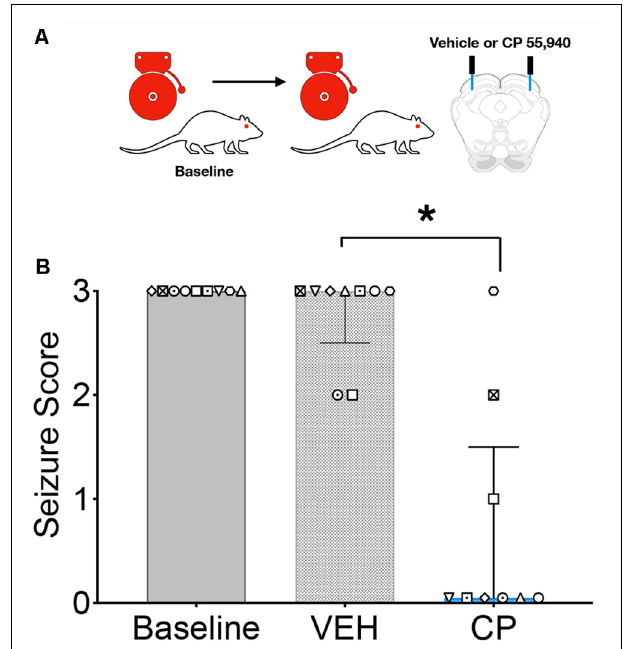
FIGURE 2 | Intracollicular injection of the CB1/2 receptor agonist, CP 55940 (CP) attenuates audiogenic seizures in GEPRs. (A) Schematic of the testing scheme; animals were tested with a baseline test session before a vehicle-treated session and a CP treated session. A baseline is shown only once, as in this experiment all animals displayed baseline scores of three across both tests. (B) Microinfusion of CP significantly decreased audiogenic seizure score as compared to vehicle (VEH) infusion into the deep layers of the superior colliculus (DLSC). Bars indicate median and interquartile range, symbols show individual subjects. * p < 0.05, according to Friedman test followed by Dunn’s post hoc test.